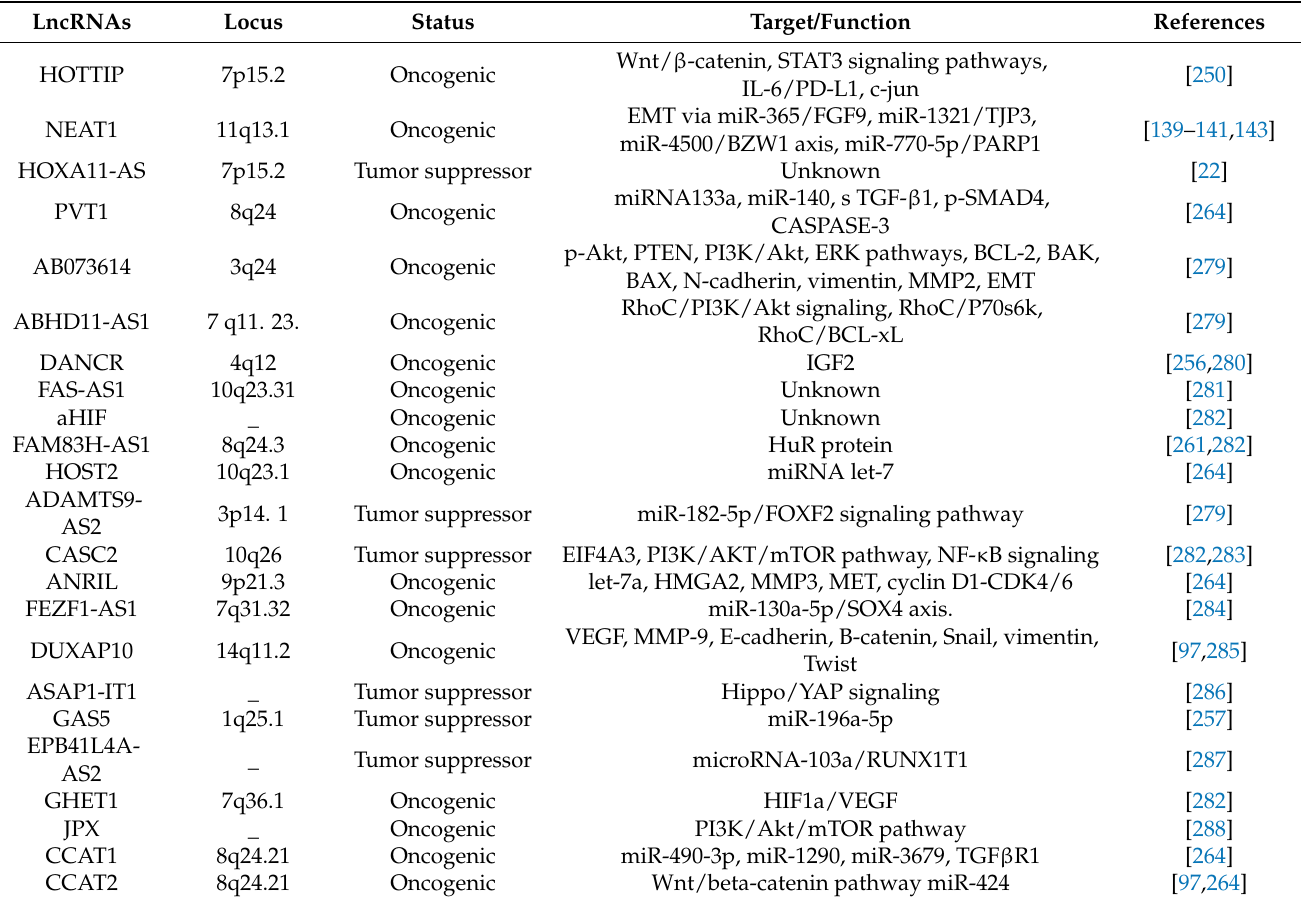
Table 4. LncRNAs involved in proliferation, invasion, apoptosis, migration, metastasis, and drug resistance in ovarian